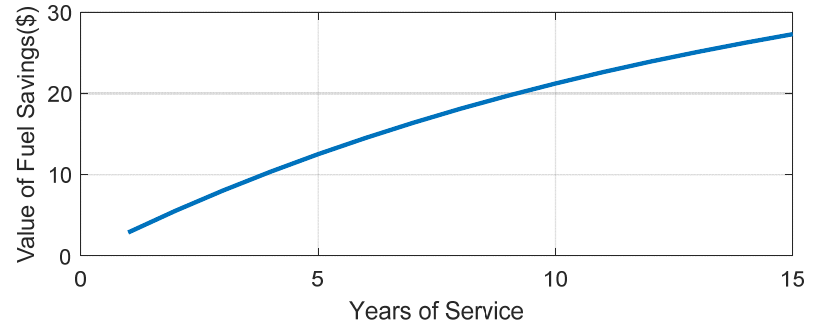
Figure 8. Estimated purchase price of diesel and electric trucks designed for 75 mile range.